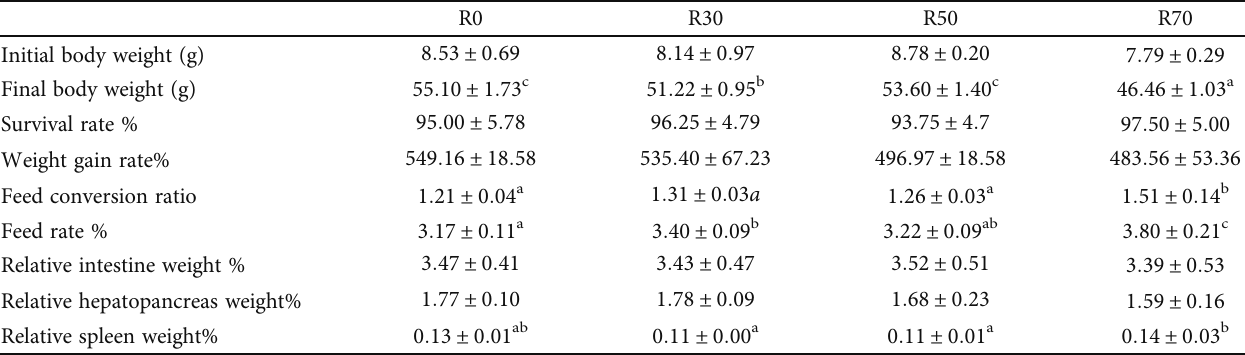
Table 5: Survival and growth performance of grass carp fed practical diets ( means ± SD , n = 4